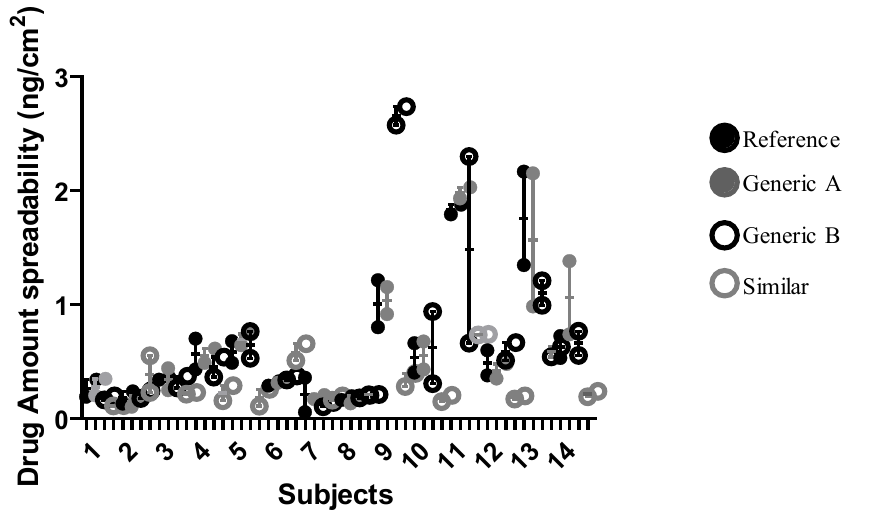
FIGURE 4 - Drug amounts per unit area (µg/cm 2 ) of the duplicate determinations in each subject for four MPC products measured after 6 hs